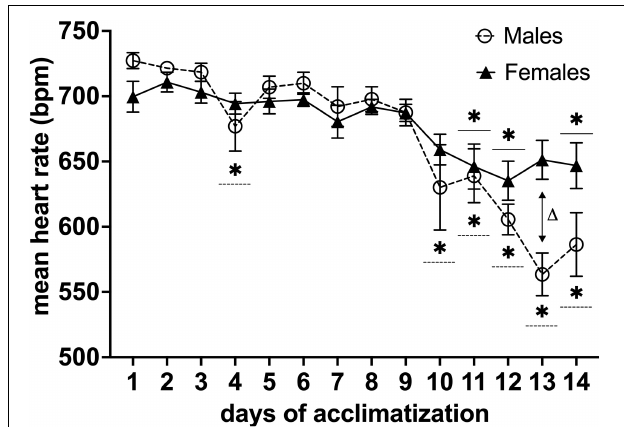
FIGURE 4 | Effects of awake MRI habituation on heart rate for male ( n = 11) and female ( n = 13) mice. ∗ P < 0.05 in a Dunnett’s test (day 1 as control). (cid:49) P < 0.05 in Holm-Sidak’s multiple comparison using two-factor mixed ANOVA with sex × days of acclimatization. Data are presented as mean ±